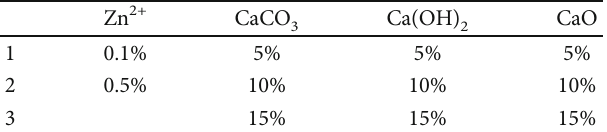
Table 2: Basic physical properties of red